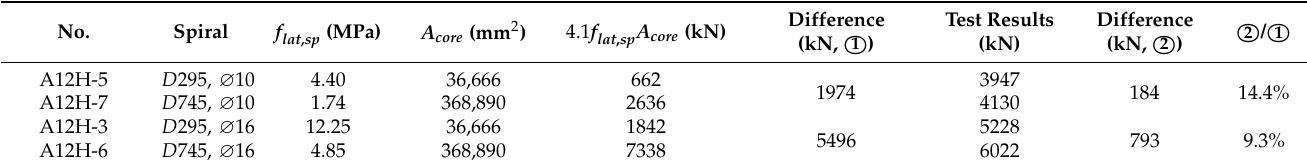
Table 4. Test strength and P s of Equation (8) according to the spiral